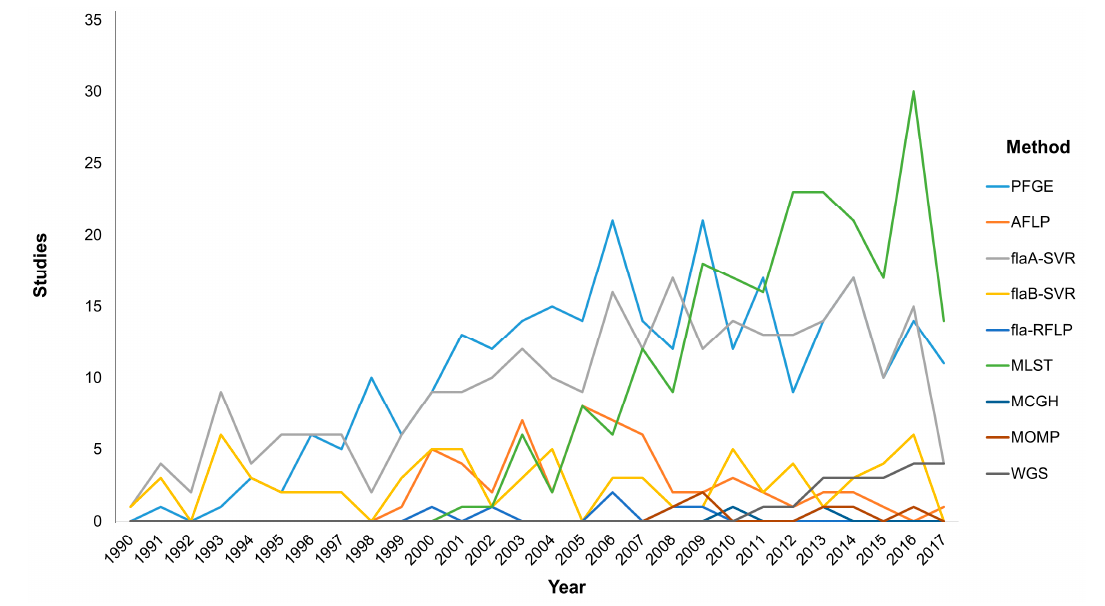
Figure 1. Graphical analysis of the applied molecular typing methodologies over time based on PubMed search. The use of molecular methodologies for the differentiation of Campylobacter at species and strain level has been modified during the last decades according to the new trends in technology, the improvements in bioinformatics, and the needs of the scientific community. Pulsed-field gel electrophoresis (PFGE), amplified fragment length polymorphism (AFLP), fla short variable region (fla-SVR), fla restriction fragment length polymorphism (fla-RFLP), multi-locus sequence typing (MLST), microarray comparative genomic hybridization (MCGH), major outer membrane protein (MOMP), whole genome sequencing (WGS).